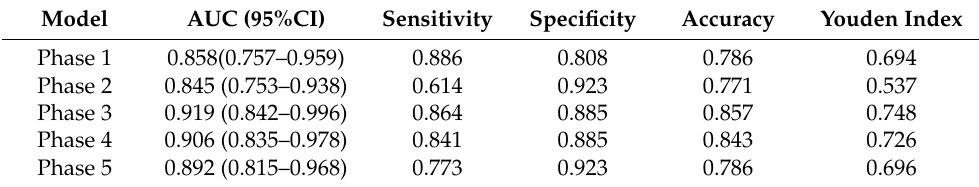
Figure 2. ROC curve for different phases. Table 3. Comparison of predictive performance of six models in the cohort.